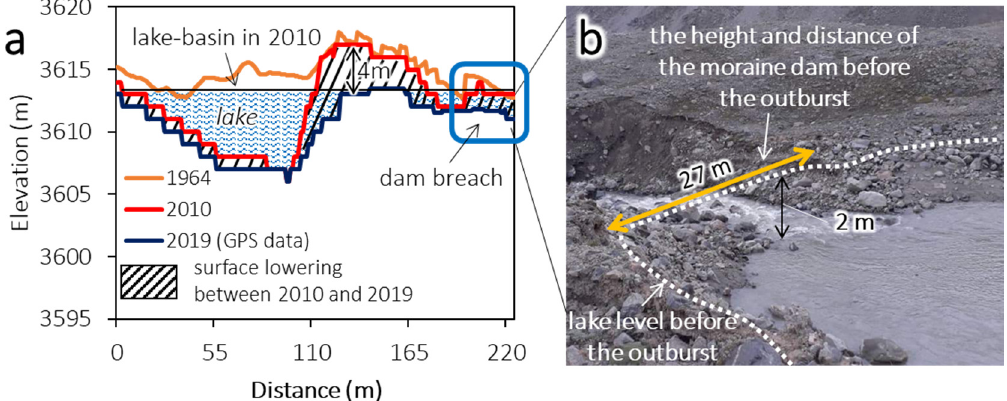
Figure 9. Basin profiles and moraine dam region. ( a ) Longitudinal profiles along the lake basin and moraine dam before and after outburst (along a–a ′ in Figure 8). The blue square shows elevation changes at the dam. The profiles were compiled based on ALOS DSM (2010) and GPS data (2019). Background orange profile from Corona KH-4A/DSM for 1964. ( b ) The breached dam region the day after the outburst (9 August 2019).